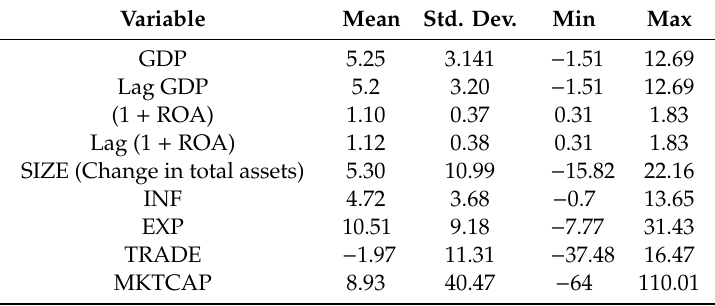
Table 5. Descriptive statistics (number of observations =